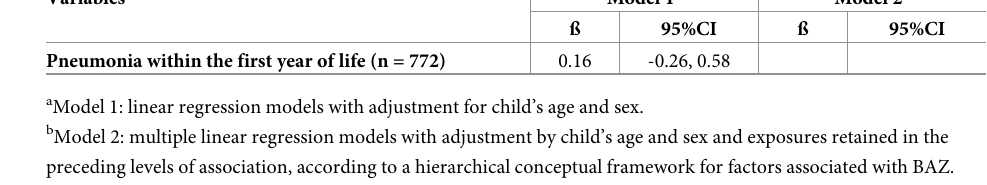
preceding levels of association, according to a hierarchical conceptual framework for factors associated with